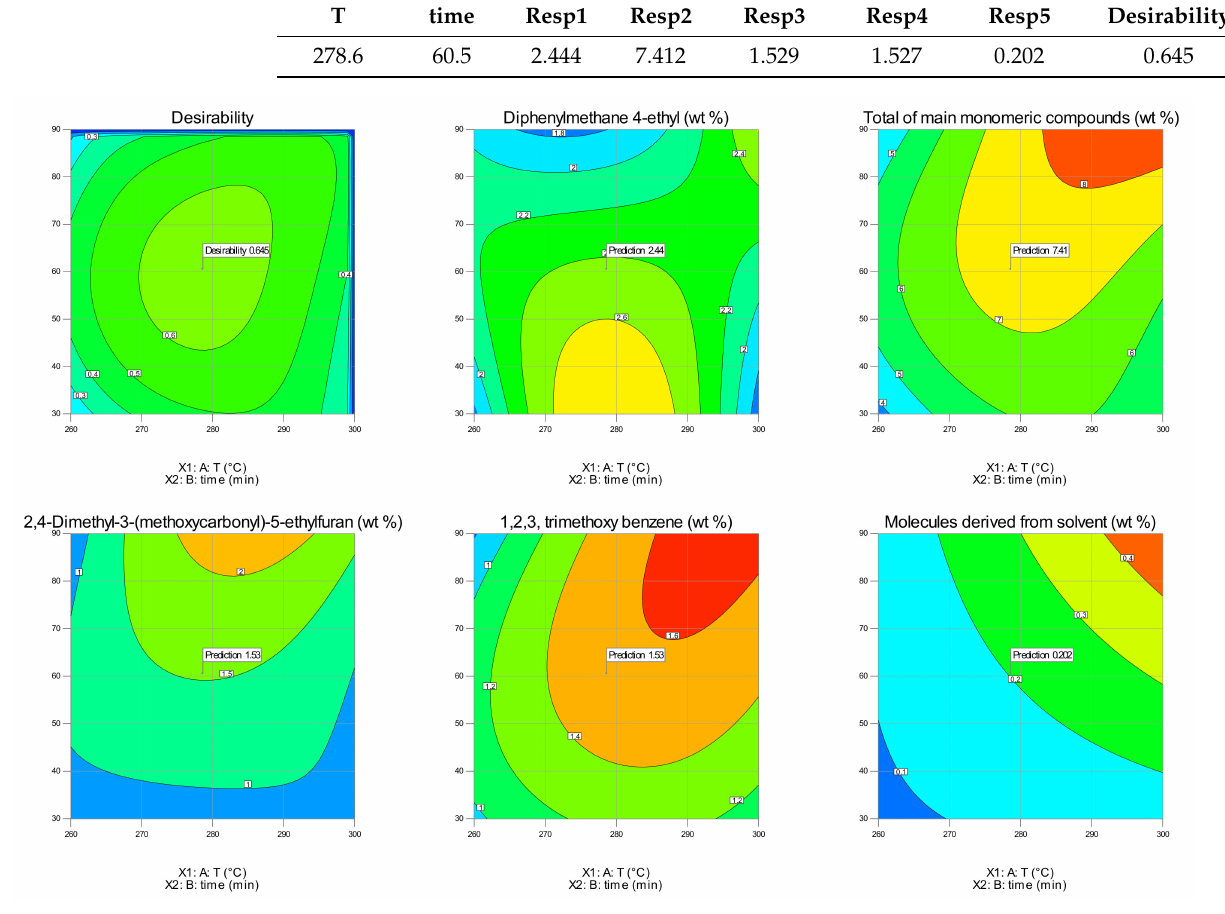
Figure 10. Position of the desired solution in the contour plot for each